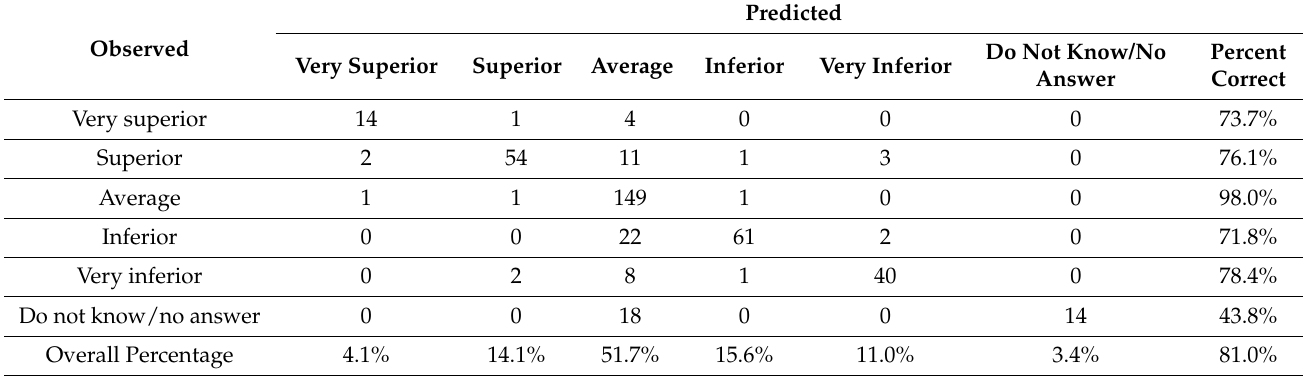
Table 2. Power of classification of citizen model.